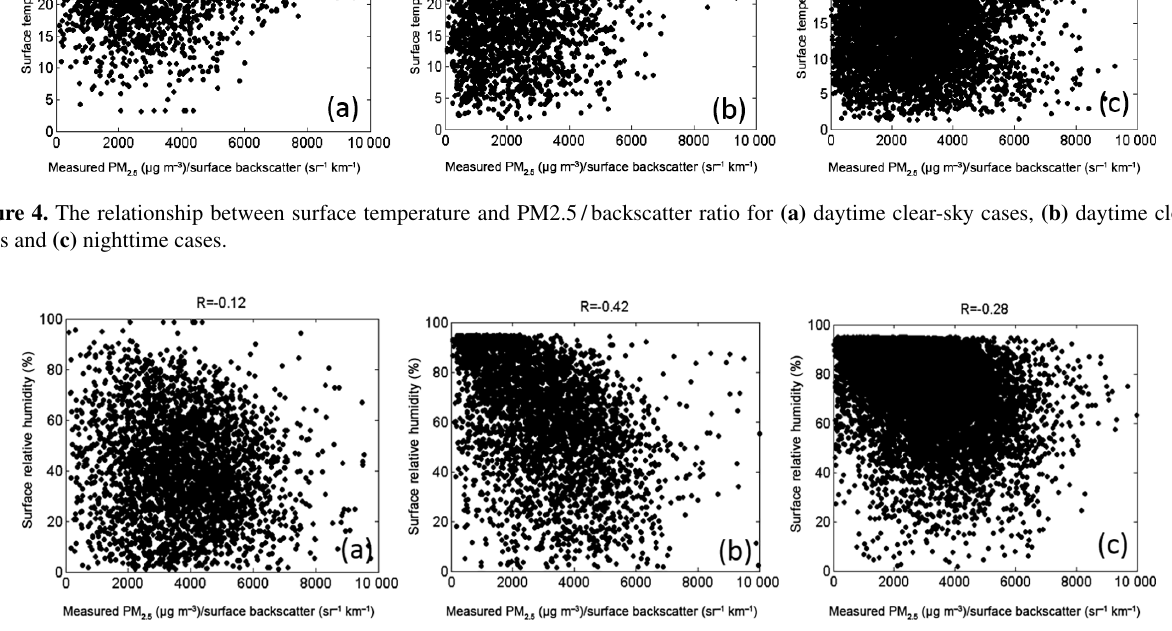
Figure 5. The relationship between surface relative humidity and PM2.5/backscatter ratio for (a) daytime clear-sky cases, (b) daytime cloudy cases and (c) nighttime